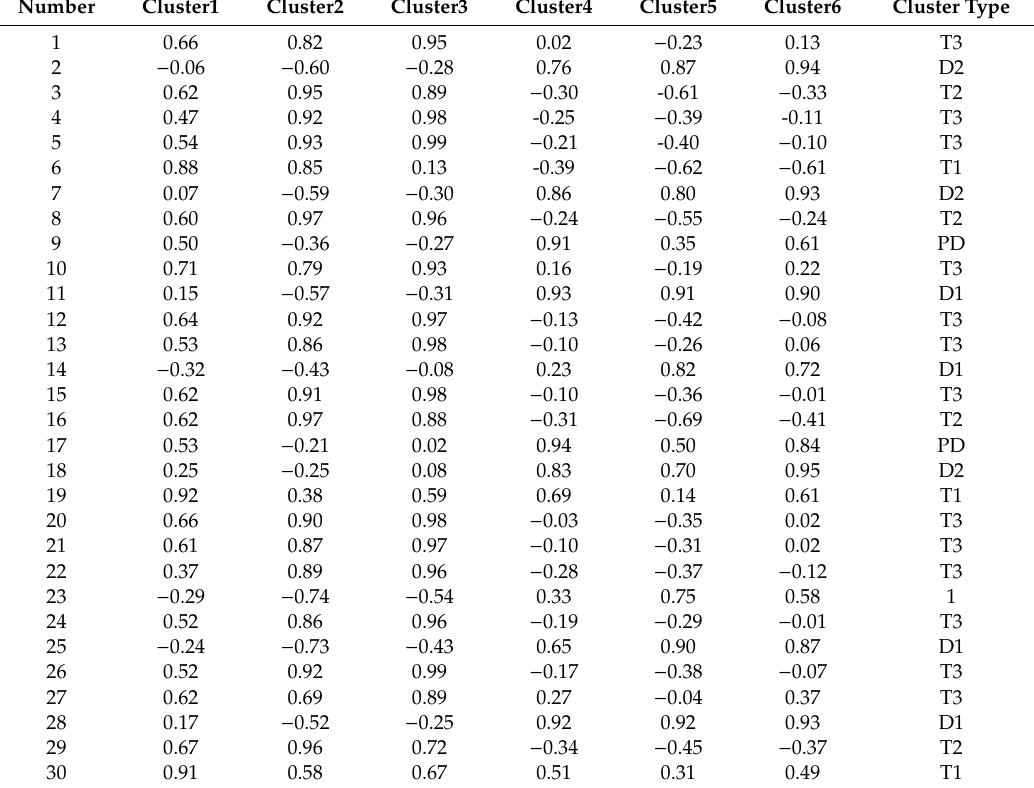
Table 6. DGA data diagnosis results using